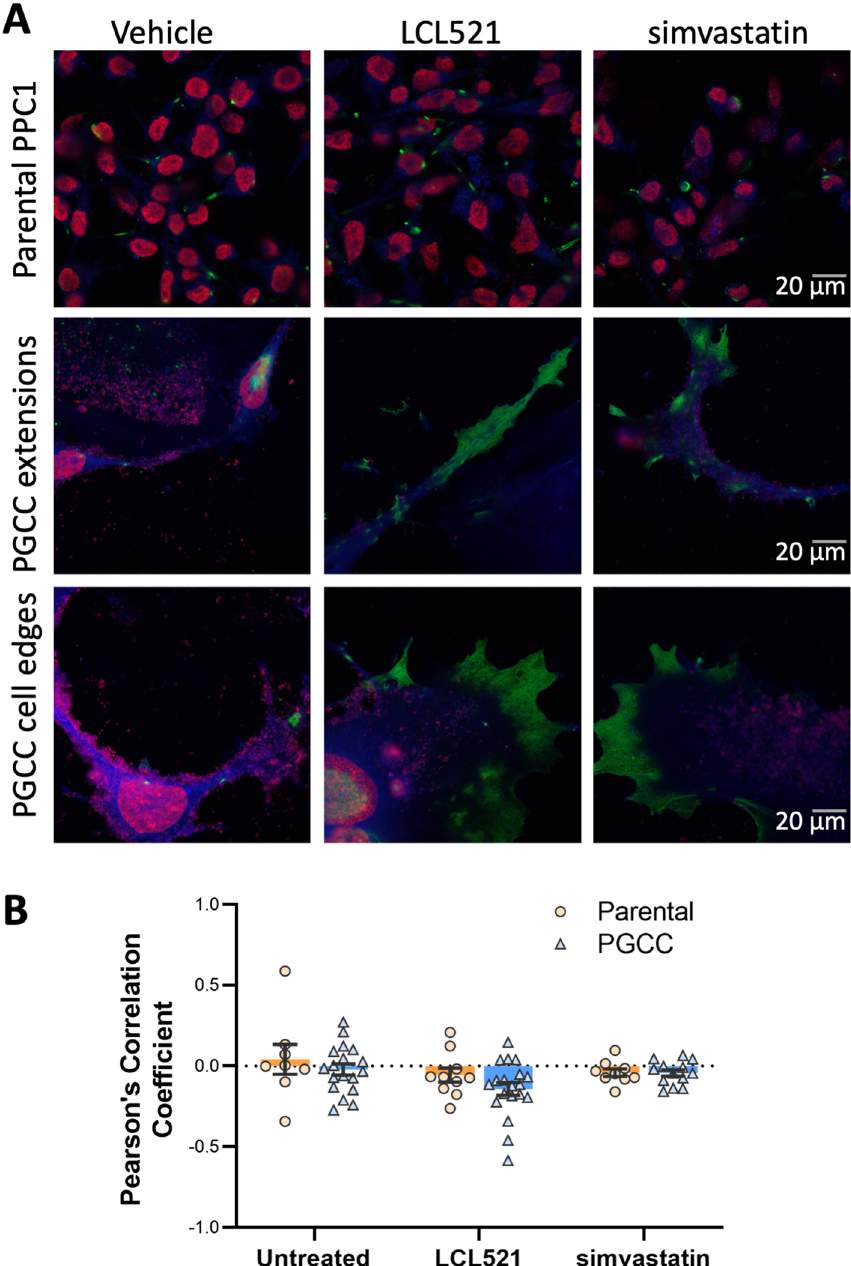
Figure 6. Ceramide and cholesterol segregate, with ceramide appearing at periphery of PGCC treated with LCL521 or simvastatin. ( A ) Uncropped 63X images were obtained of parental cells or PGCC treated with 5 µM LCL521 or 1 µM simvastatin for 48 h. Green indicates ceramide staining, which appears at cellular termini in treated PGCC. Blue indicates filipin staining of cholesterol and red indicates SYTOX deep red staining of nucleic acids. ( B ) Quantification of ceramide/cholesterol signal colocalization across all samples and conditions, showing a durable lack of colocalization for the